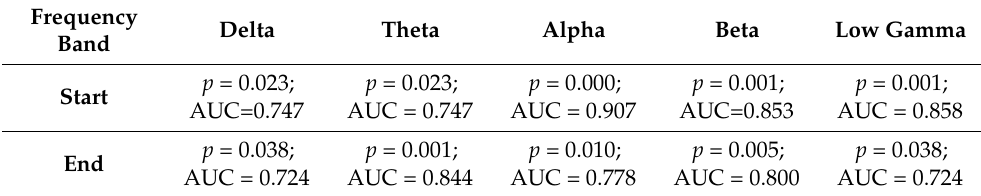
Table 3. AUC with “Start” and “End” conditions, compared to patients.